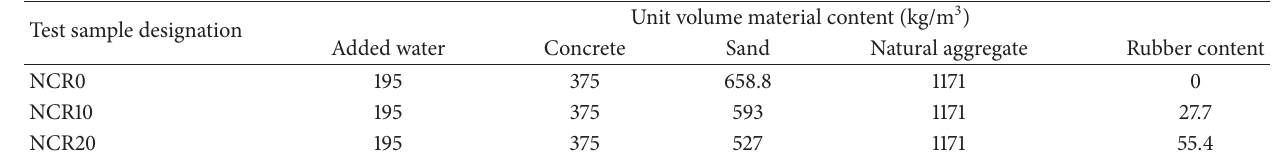
Table 1: Rubber concrete mix